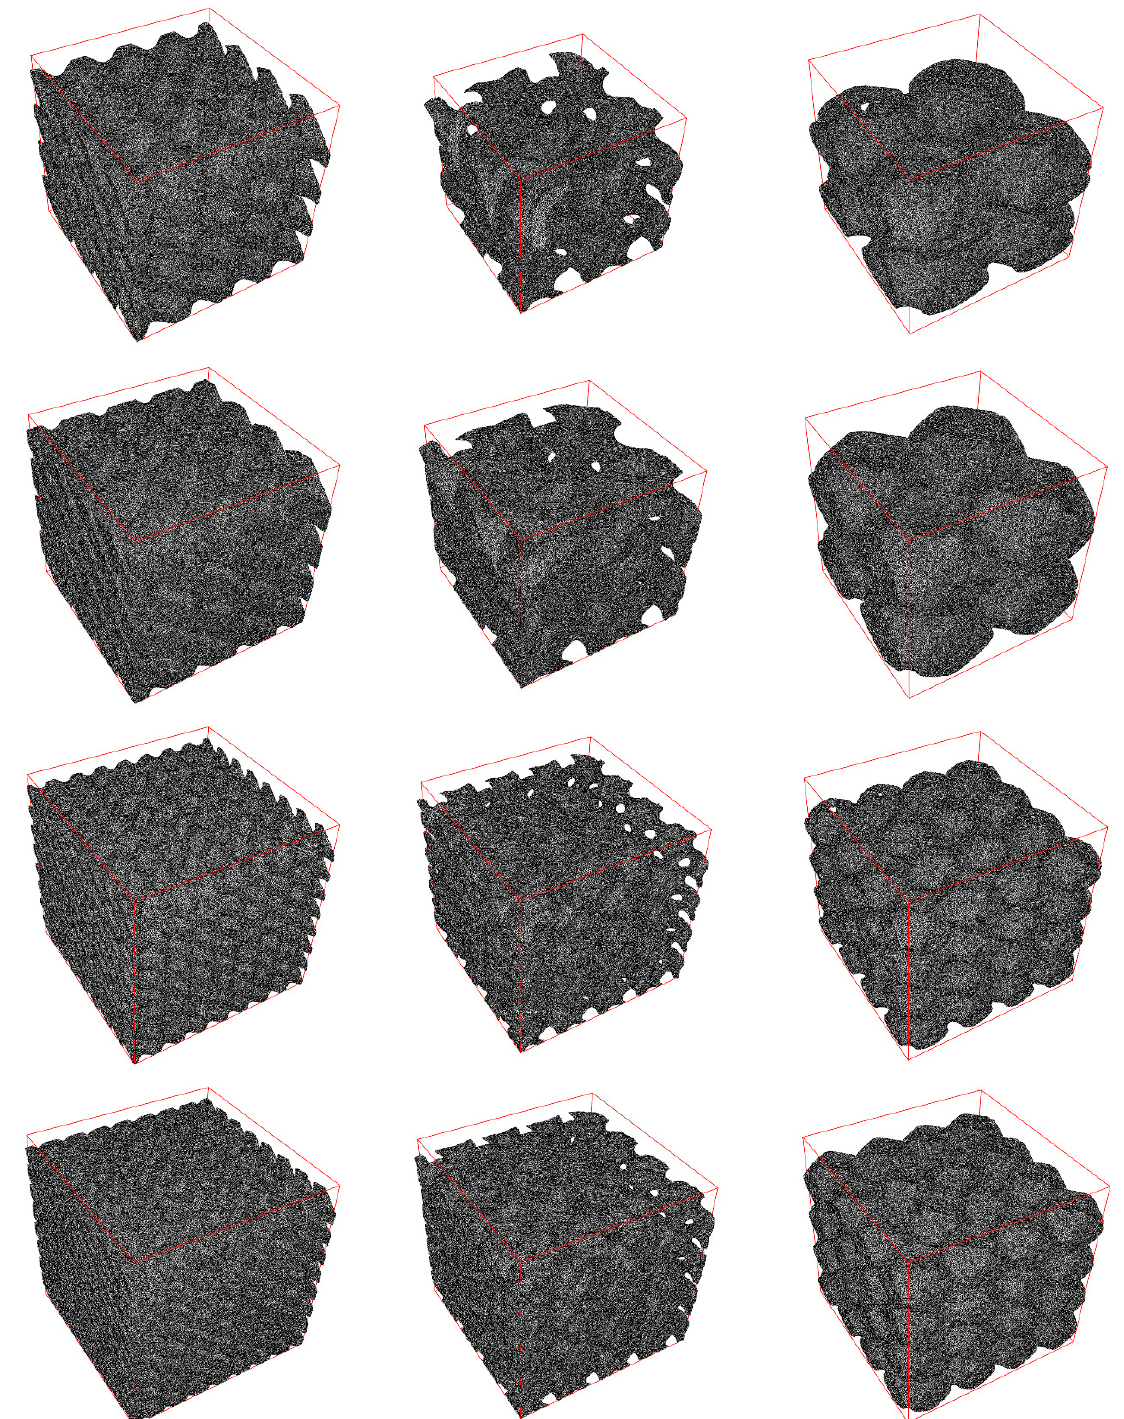
Figure 5. Mesh deformation. Columns from left to right: diamond (D) surface, gyroid (G) surface, primitive (P) surface. Rows from top to bottom: 2 cells, relative thickness δ = 0.125; 2 cells, relative thickness δ = 0.2; 4 cells, relative thickness δ = 0.125; 4 cells, relative thickness δ = 0.2.